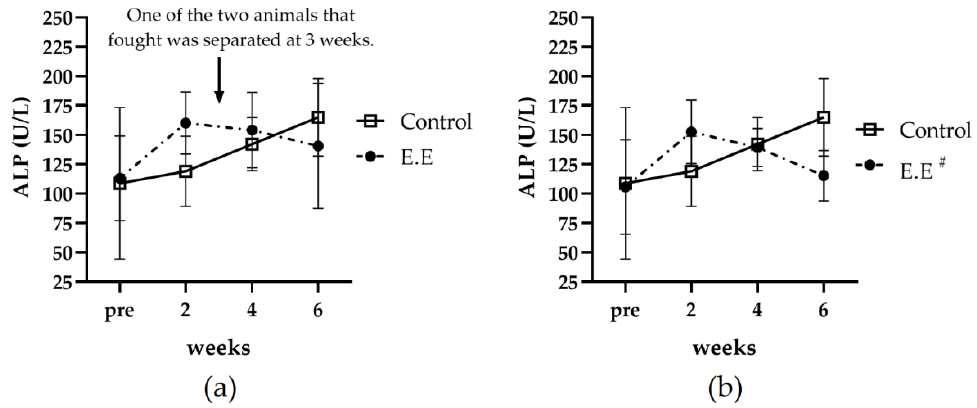
Figure 6. Change in ALP activity at 2-week intervals, including before environmental change of placing them into the cages (pre) for a total of 6 weeks when the fighting dog was ( a ) included and ( b ) not included. E.E: Environmental enrichment group. # Except for one dog that fought.